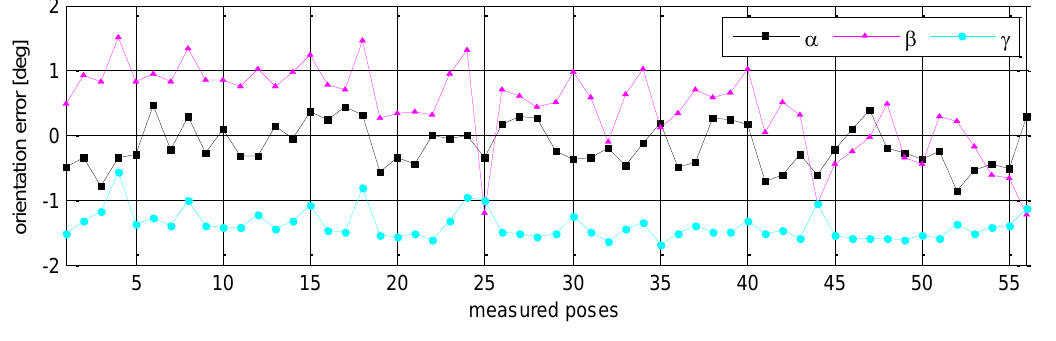
Figure 10. Robot orientation accuracy after calibration (pose set Q